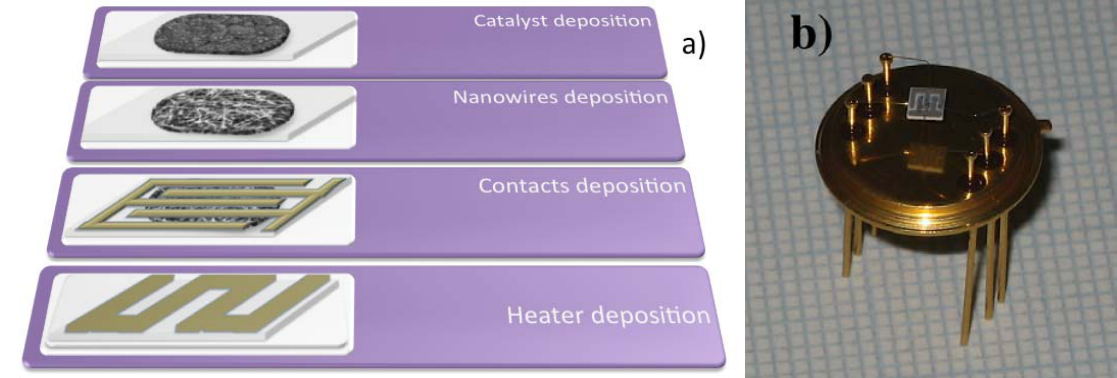
Figure 5. Different steps for the preparation of nanowires based chemical sensors ( a ); sensor prototype ( b ).